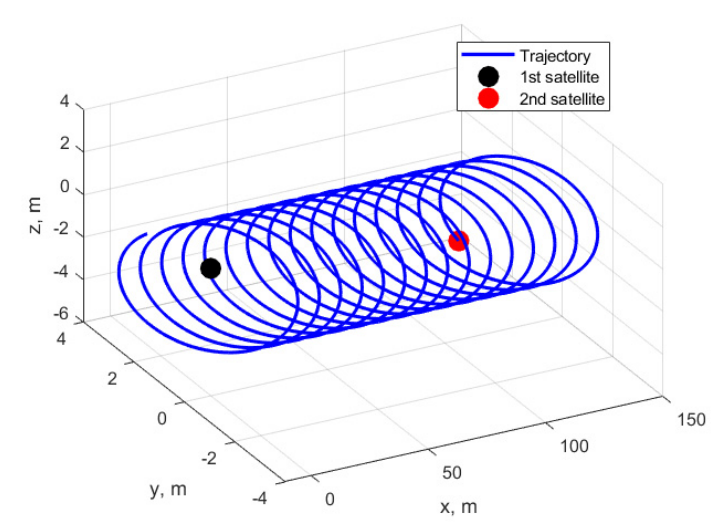
Figure 3. Relative trajectories of the two satellites’ free relative motion.